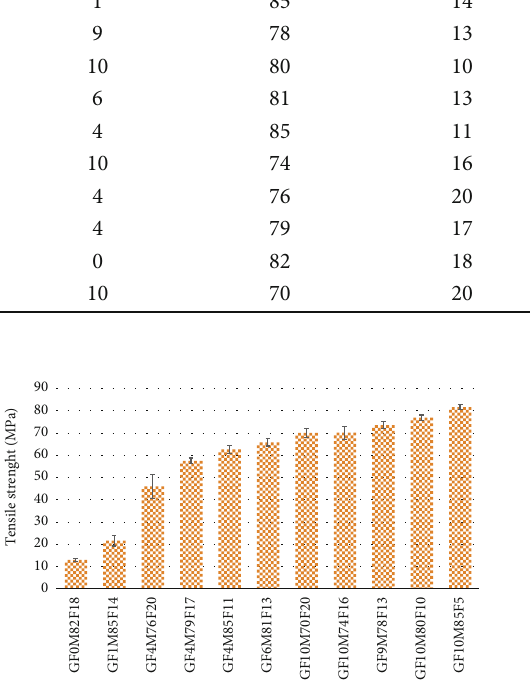
Figure 7: The maximum of the average tensile strength of